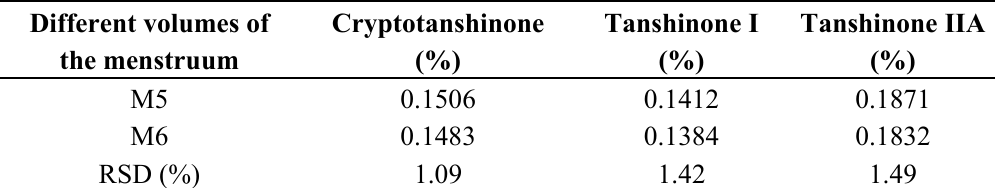
Table 2. A comparison of the use of different volumes of the menstruum (n = 3). Different volumes of